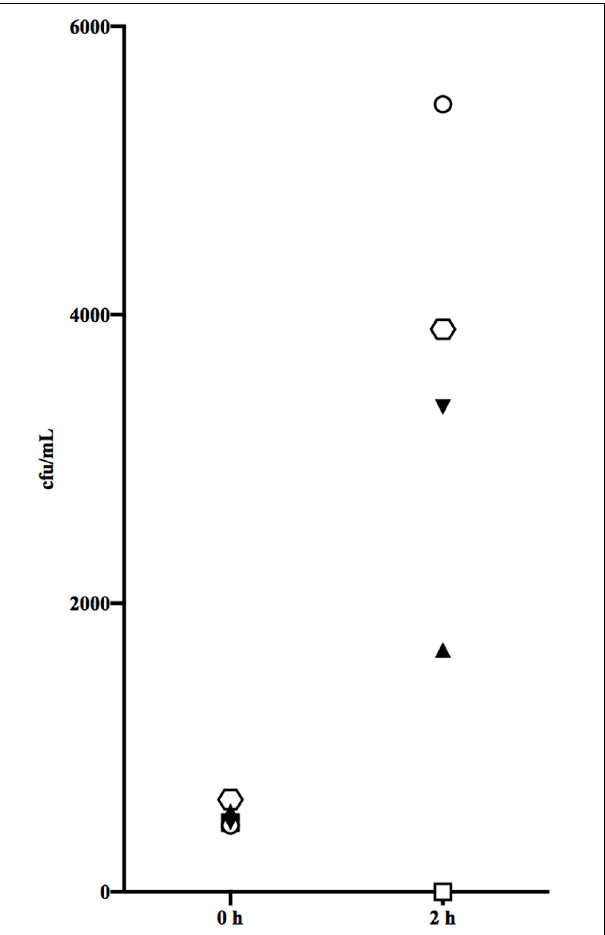
FIGURE 3 | Bactericidal assay measured the functional activity of antibodies in the acute serum from the third episode and convalescent serum. Acute serum from episode 3 (triangle), with IdeS added (inverted triangle) and convalescent serum (hexagon), with IdeS added (circle) and no beta lactamase added (quadrangle). The result presented is from one representative